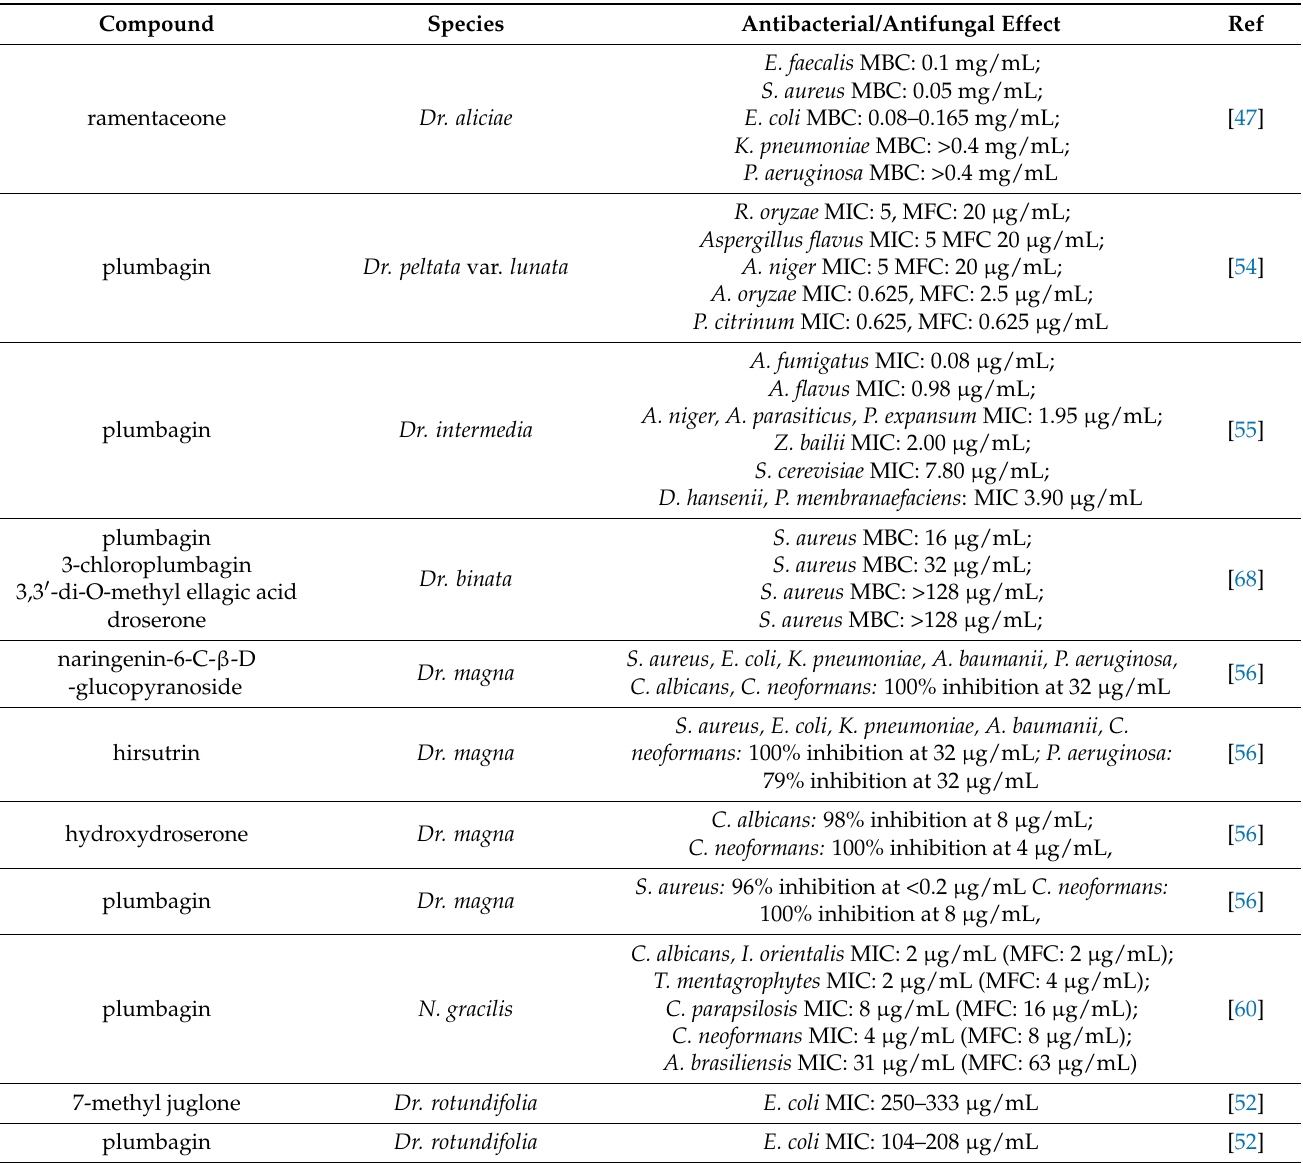
Table 2. Antibacterial and antifungal activity of isolated components from the Droseraceae and Nepenthaceae